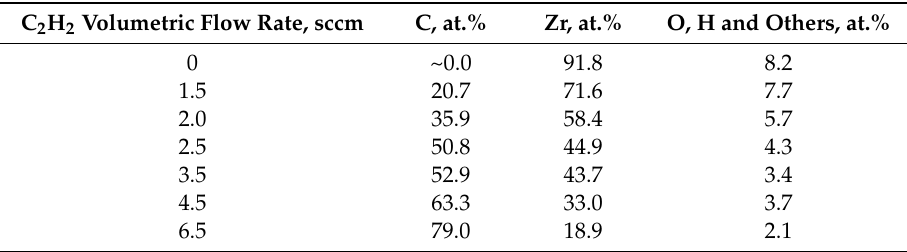
Table 1. Chemical composition of the Zr–C coatings.